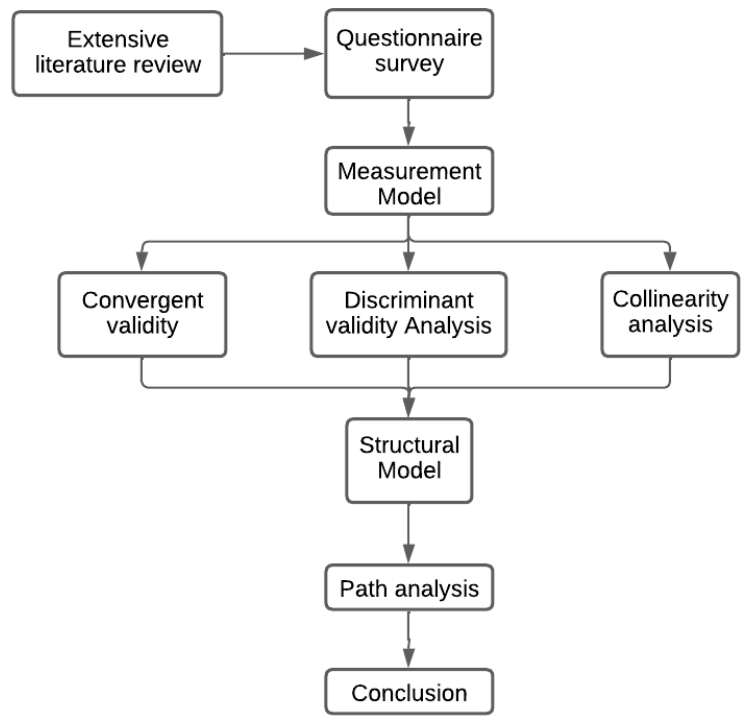
Figure 2. Research design